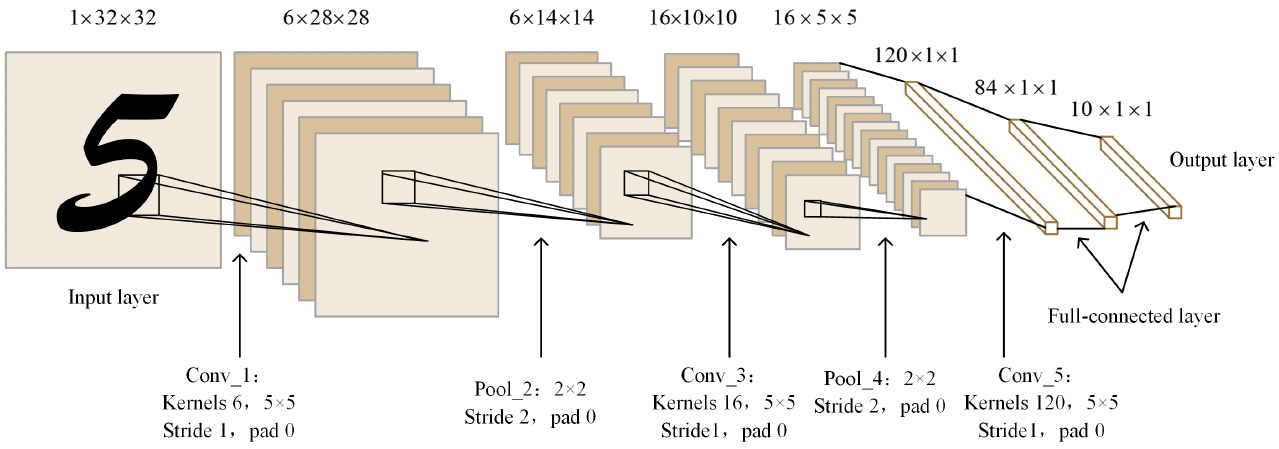
Figure 7. The architecture of the LeNet-5 network. The output shape is channel × height × width. Each convolutional layer uses size 5 × 5, padding 0, strides 1. Each pooling layer size 2 × 2 and strides